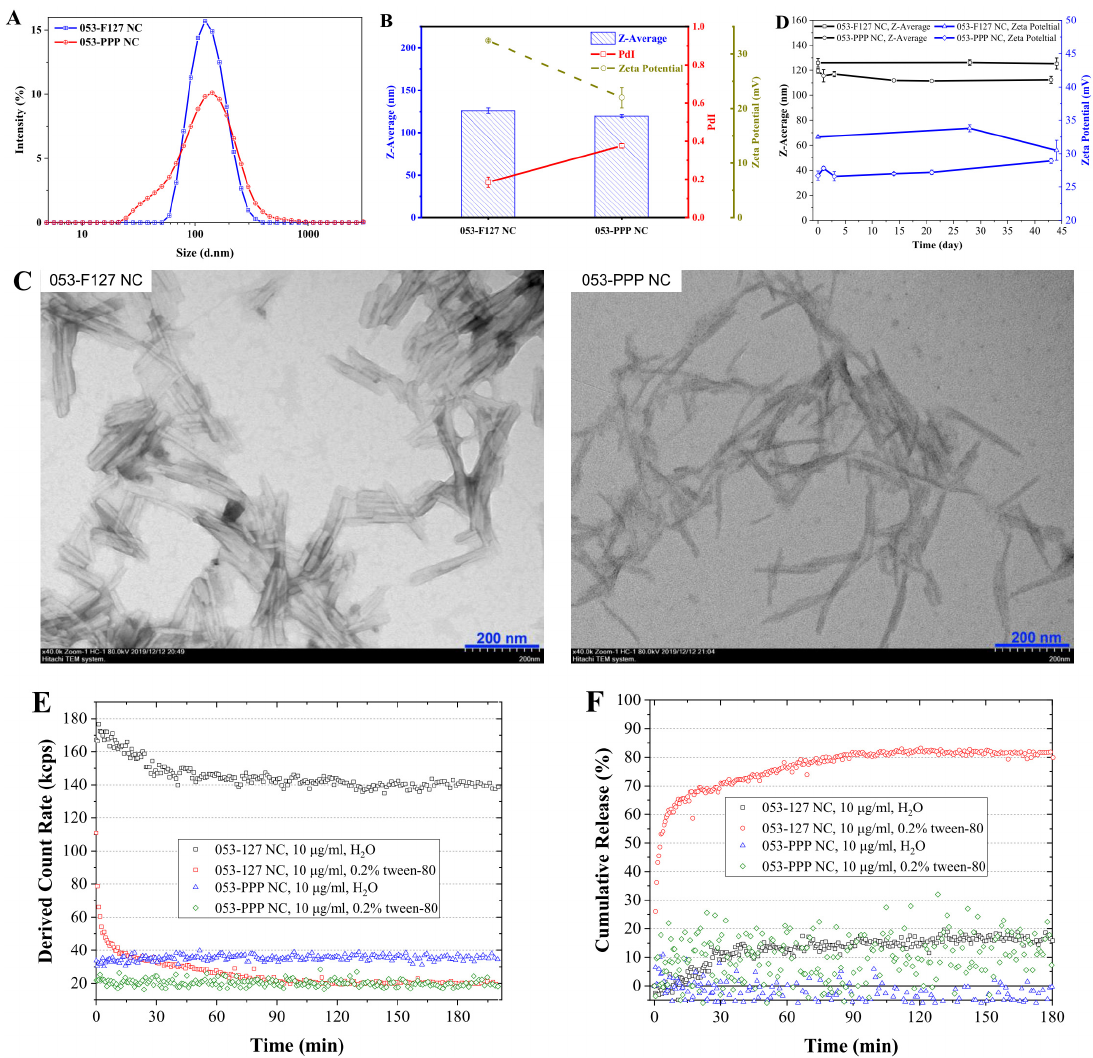
Figure 3. ( A ) Size distribution and ( B ) Z-average, PdI, and zeta potential of 053-F127 nanocrystal and 053-PPP nanocrystal micelles determined by dynamic light scattering (DLS). ( C ) Morphology images of 053-F127 nanocrystal and 053-PPP nanocrystal micelles from TEM at an accelerated voltage of 100 kV. ( D ) Stability study of 053-F127 nanocrystals and 053-PPP nanocrystal micelles by monitoring Z-average and Zeta Potential in water using dynamic light scattering (DLS). ( E ) Real-time monitoring of in vitro release behavior of 053-F127 NC and 053-PPP NC micelle, and ( F ) normalized cumulative release vs. time.